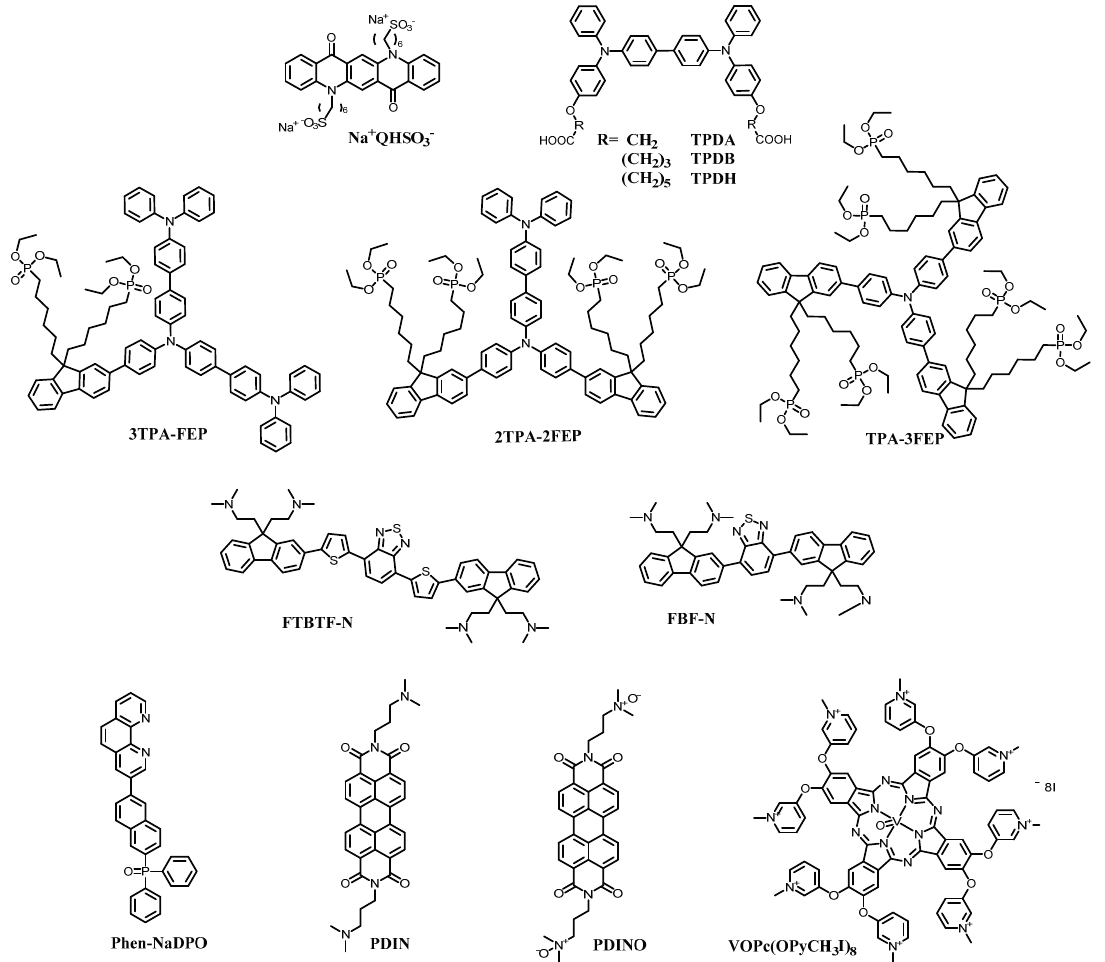
Figure 9. Chemical structures of small molecule used as interfacial layer materials for polymer solar